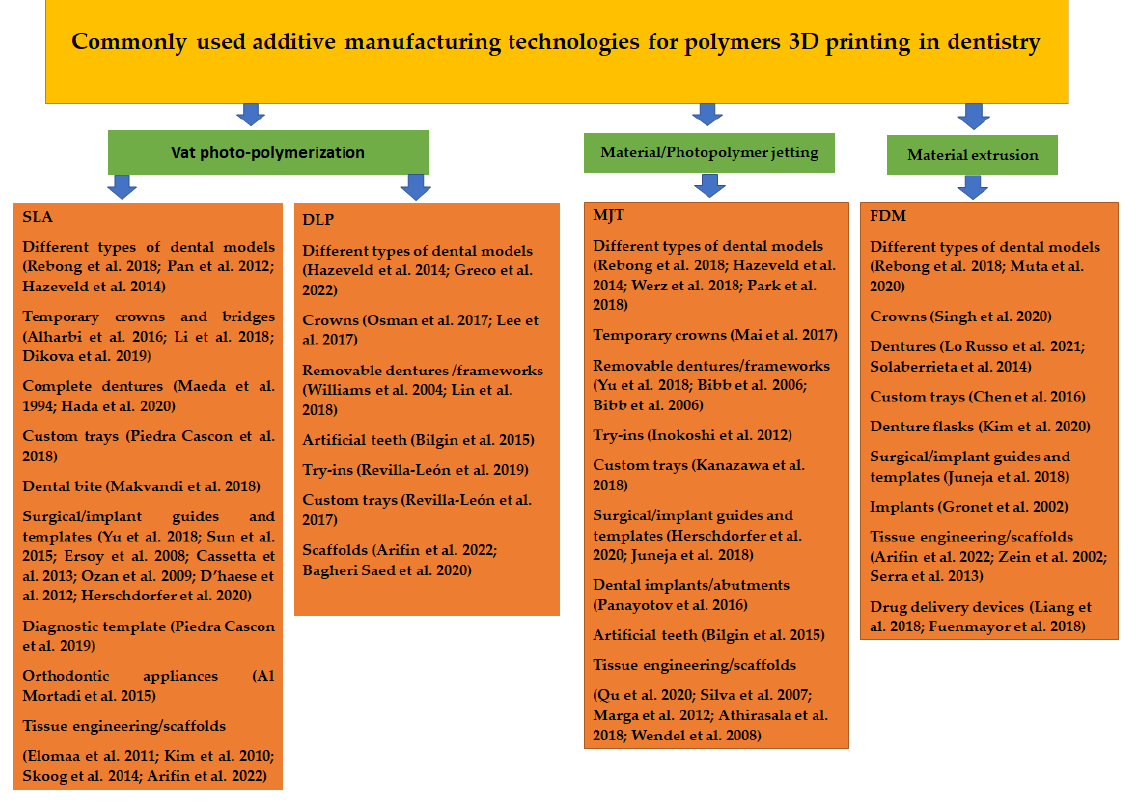
Figure 3. Most used additive manufacturing technologies and their applications for polymers 3D printing in dentistry